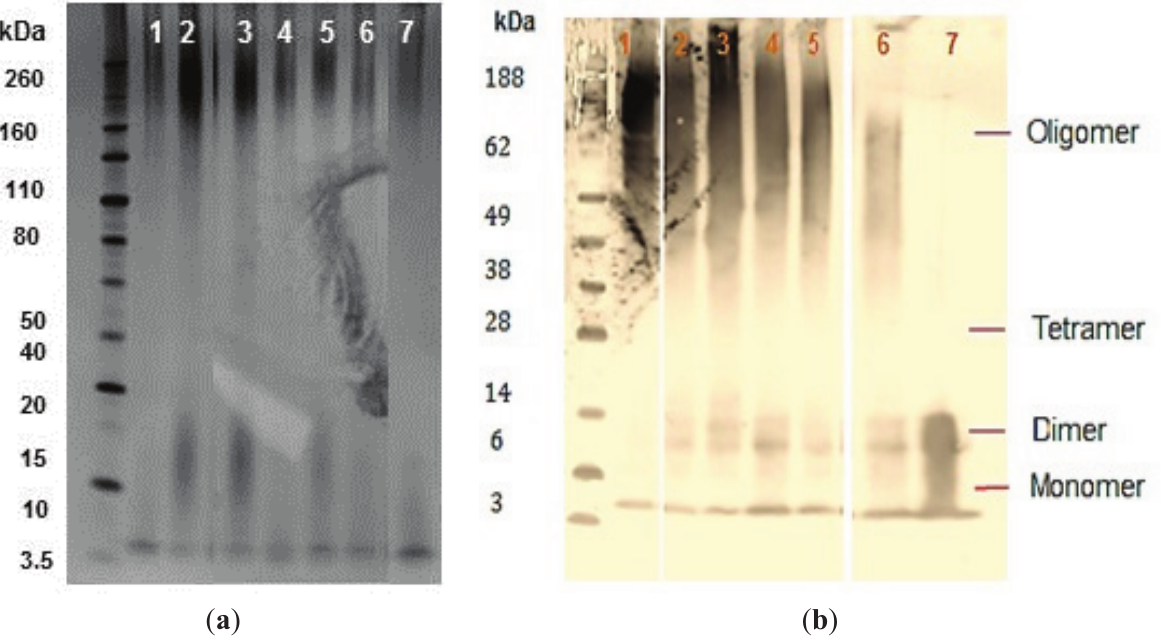
Figure 6. SDS-PAGE analyses of A(cid:2) 42 conformers in the presence and absence of compounds. ( a ) Peptide solutions co-incubated with the selected phenolic compounds were fractioned by SDS-PAGE electrophoresis (4%–12% Bis-Tris gel). One hundred nanograms of each A(cid:2) 42 sample were analyzed by silver staining. Samples are vehicle buffer control and A(cid:2) 42 (lane 1), salvianolic acid B (lane 2), rosmarinic acid (lane 3), 2,5-DHBA (lane 4), 3,4-DHCA (lane 5), 3,4,5-THBA (lane 6), and freshly prepared A(cid:2) 42 (lane 7). Lane M contains molecular weight marker. Half a microgram of each A(cid:2) 42 sample (from TEM experiment) was also analyzed by immunoblotting (Section 2.4) using anti-A(cid:2) WO2 antibody; ( b ) 0.5 (cid:7)g of each A(cid:2) 42 sample (from TEM experiment) was also analyzed by immunoblotting using anti-A(cid:2) WO2 antibody. Samples are salvianolic acid B (lane 1), rosmarinic acid (lane 2), 2,5-DHBA (lane 3), 3,4-DHCA (lane 4), 3,4,5-THBA (lane 5), vehicle buffer control and A(cid:2) 42 (lane 6), and freshly prepared A(cid:2) 42 (lane 7). Molecular weight markers are shown in lane